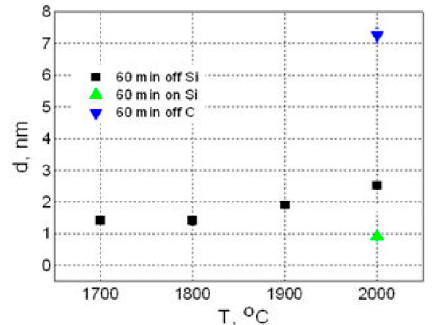
Figure 21. Graphene/graphite thickness vs. temperature for different faces of 8° off-oriented 4H-SiC samples and identical deposition time of 60 min. An on-axis sample is shown for comparison [21].